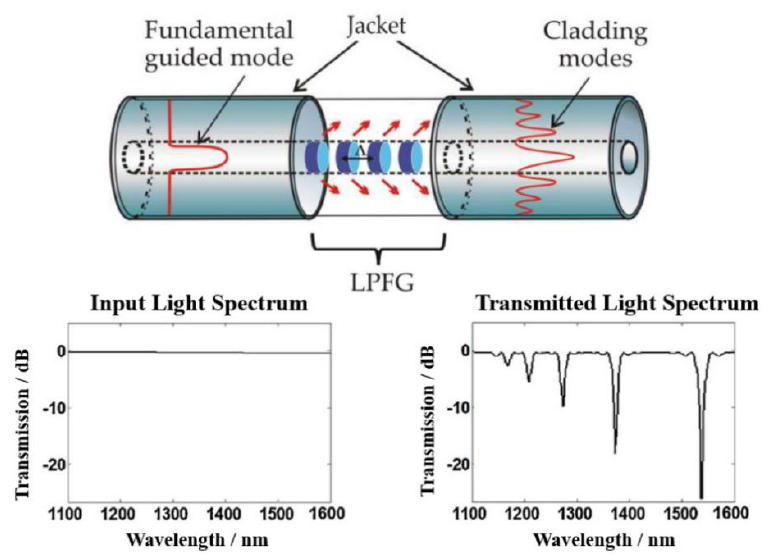
Figure 7. Light spectrum data indicating presence of anomalies [71].